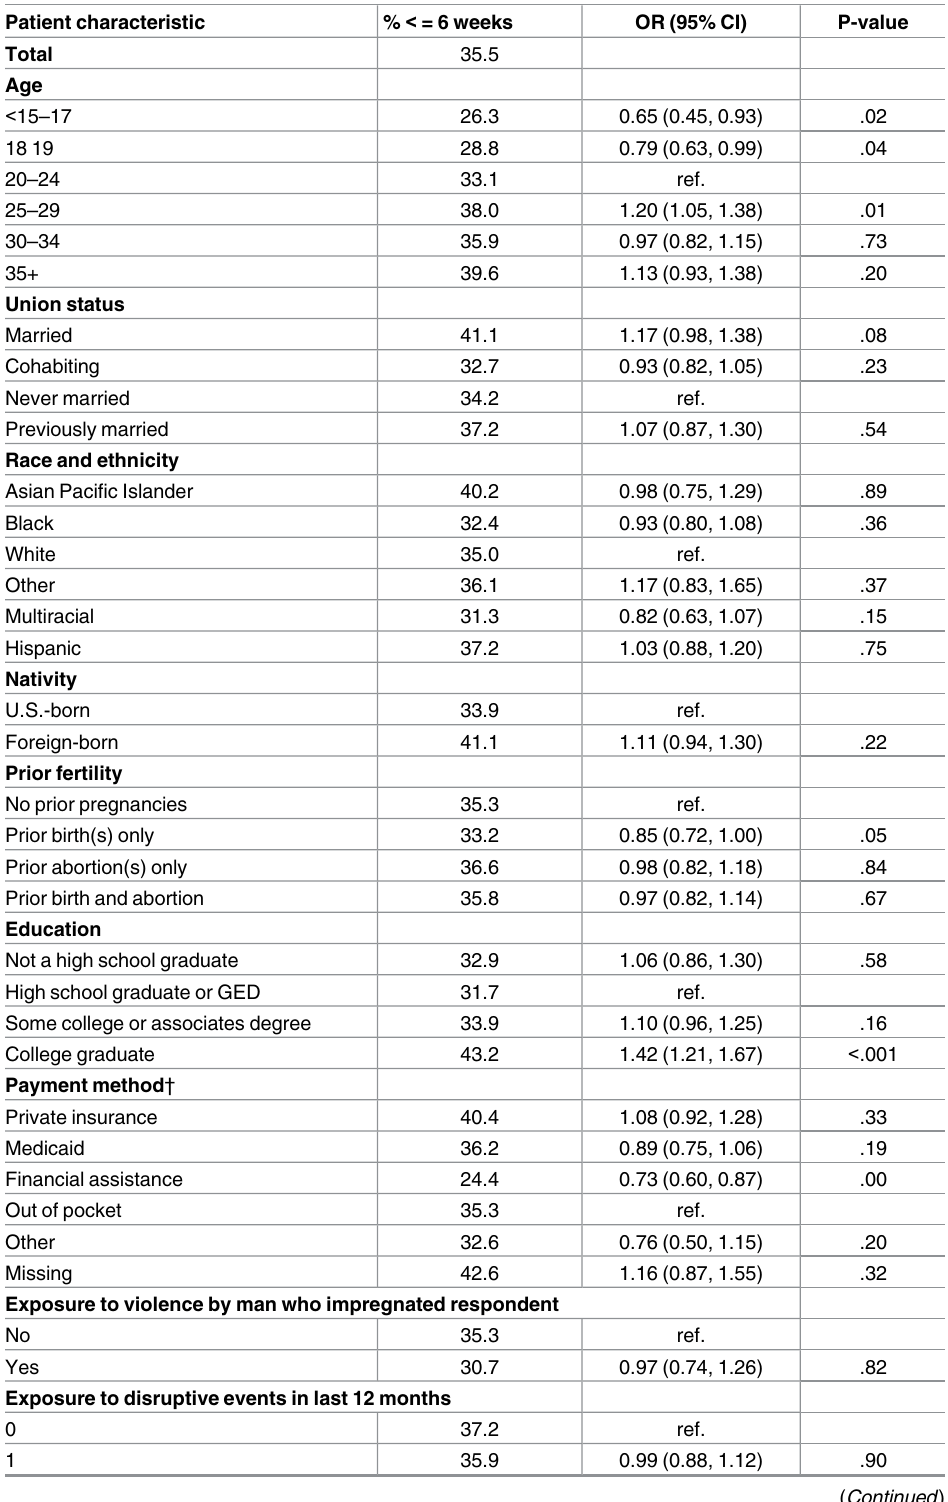
Table 2. Frequency of very early abortion by patient characteristics and odds ratios from mixed- effectslogistic regression models examining characteristics associated with very early